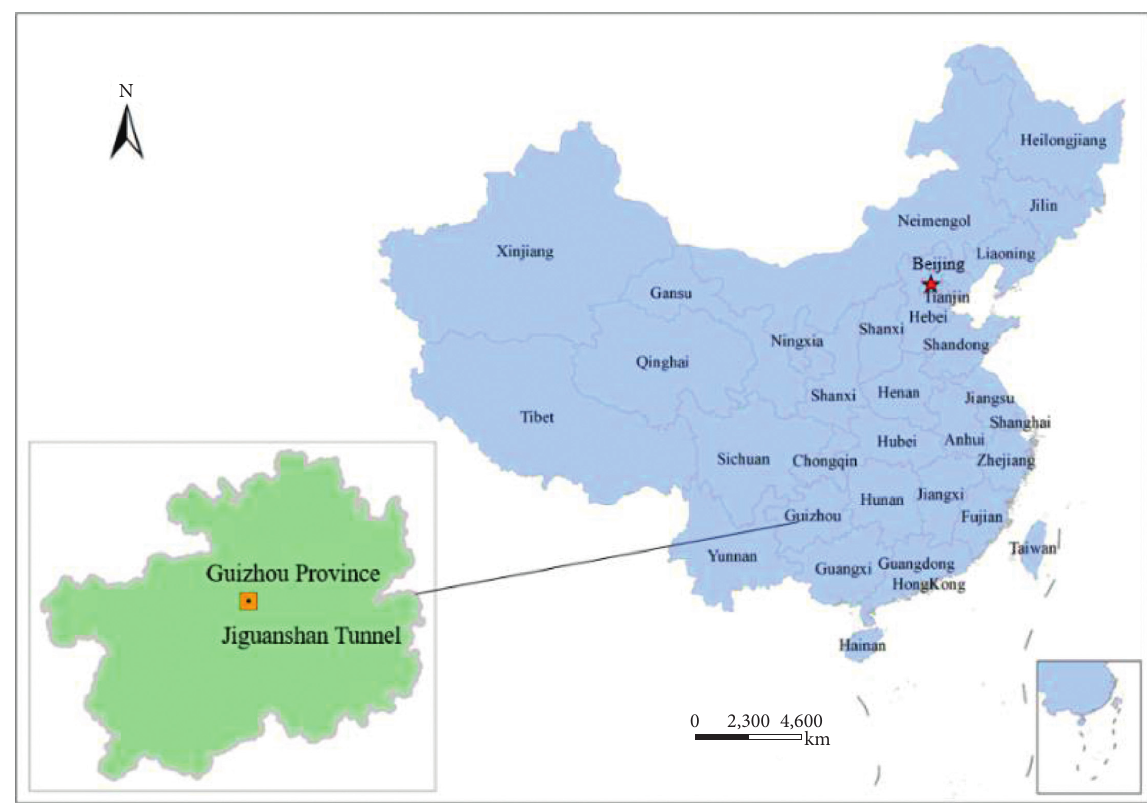
Figure 2: Location of Jiguan Mountain tunnel.